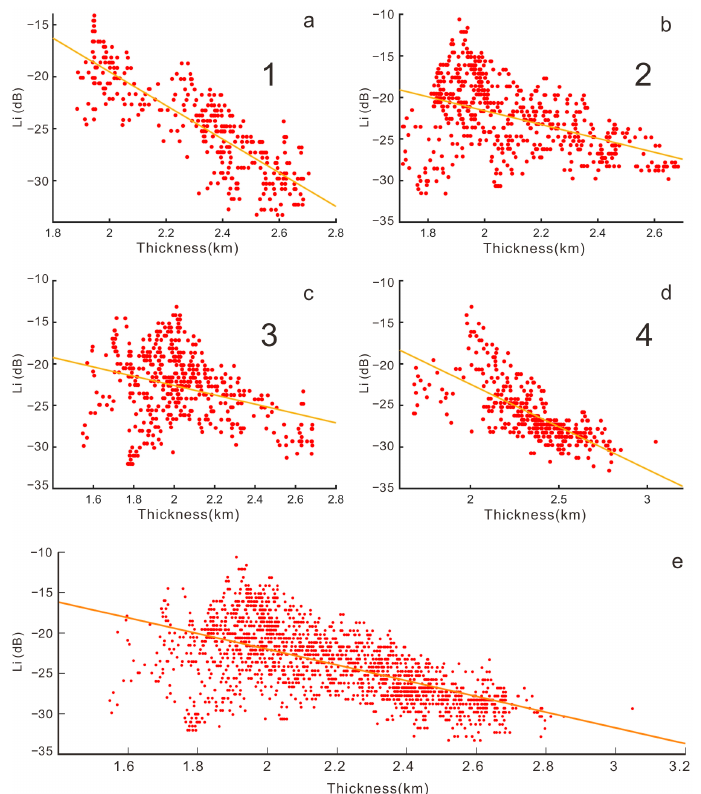
Figure 3. Absorption loss (red points) radar data of the CHINARE 21 compared with linear trends (orange lines) with slopes of about 15 dB/km, 5.7 dB/km, 8.4 dB/km, 11 dB/km, and 9.7 dB/km ( a – d ): absorption loss radar data of four triangles of CHINARE 21 in Dome A region, ( e ): all radar data of CHINARE 21 in Dome A